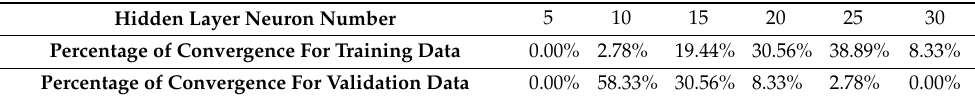
Table 8. Required number of hidden layer neurons for reaching 97% convergence on the 36 datasets.